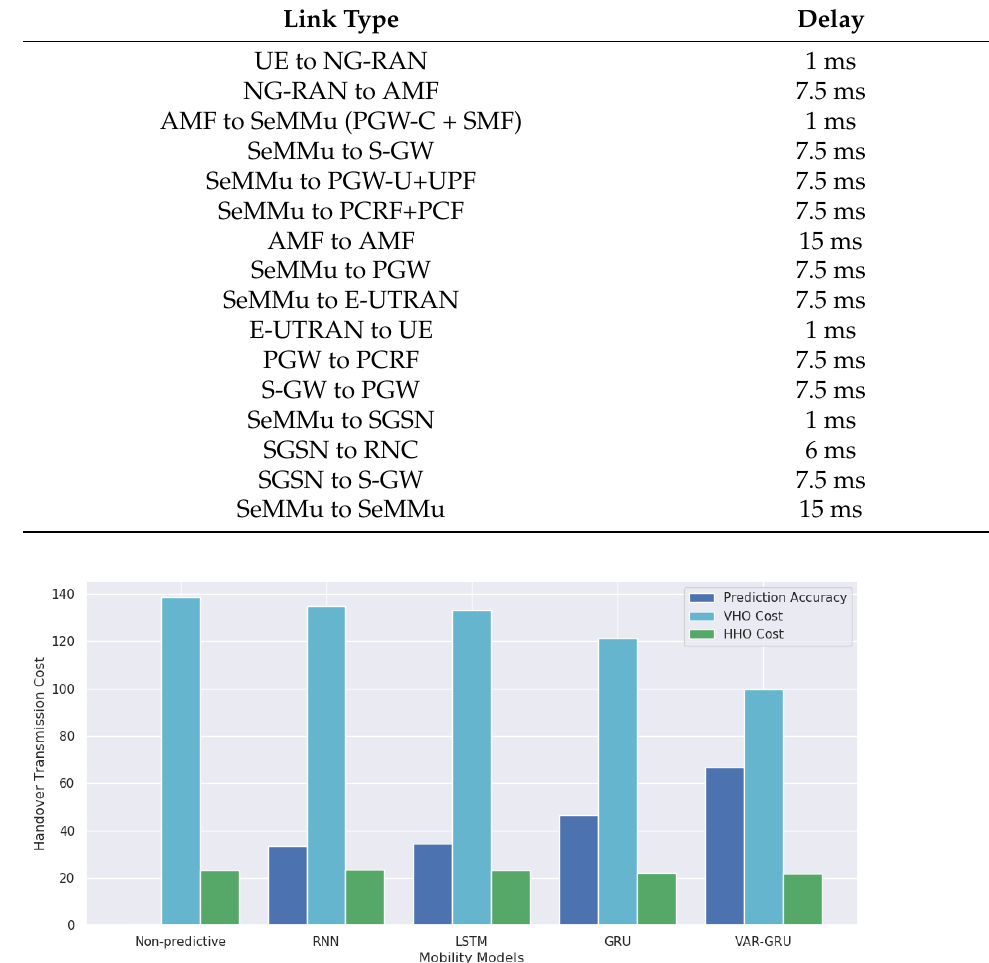
Table 4. The delay regarding each link type in rgw HO procedure [10,25].